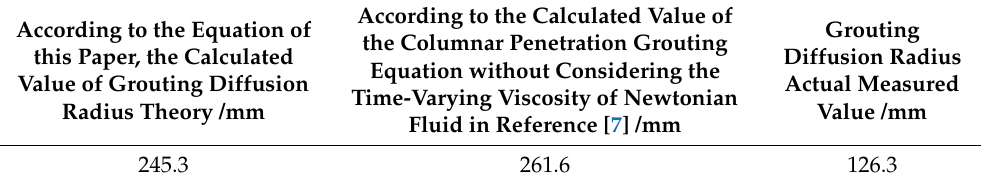
Table 1. Theoretical calculation value and actual measurement value of diffusion radius of the grouting